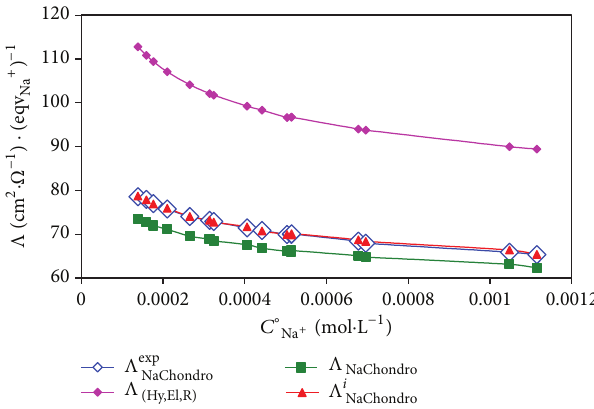
Figure 5: Comparison between variations with 𝐶 of experimen- Na + , blue points) and theoretical equivalent conduc- tal ( Λ exp NaChondro without dielectric friction; Λ with dielectric tivities ( Λ Hy , El , R NaChondro friction in absence of interference; Λ 𝑖 with dielectric friction NaChondro in presence of interference) of sodium chondroitin sulfate in water at 25 ∘